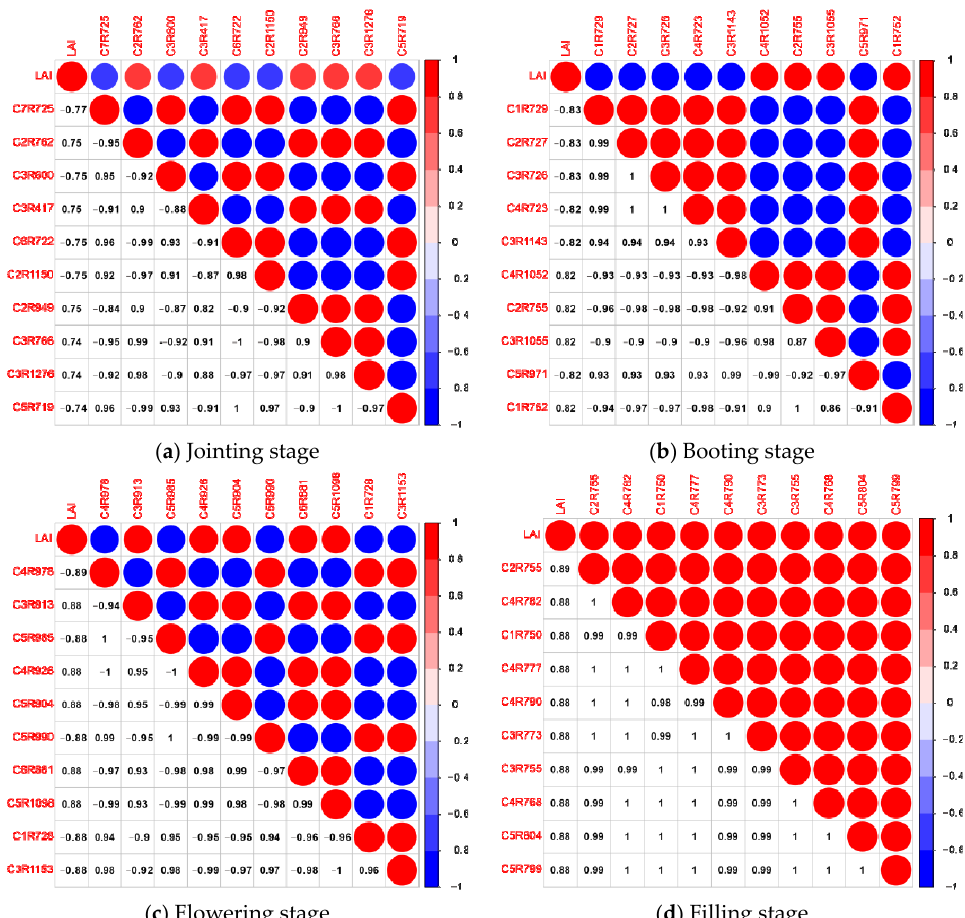
Figure 7. Correlation analysis of selected wavelet energy coefficient and leaf area index at different growth stages.